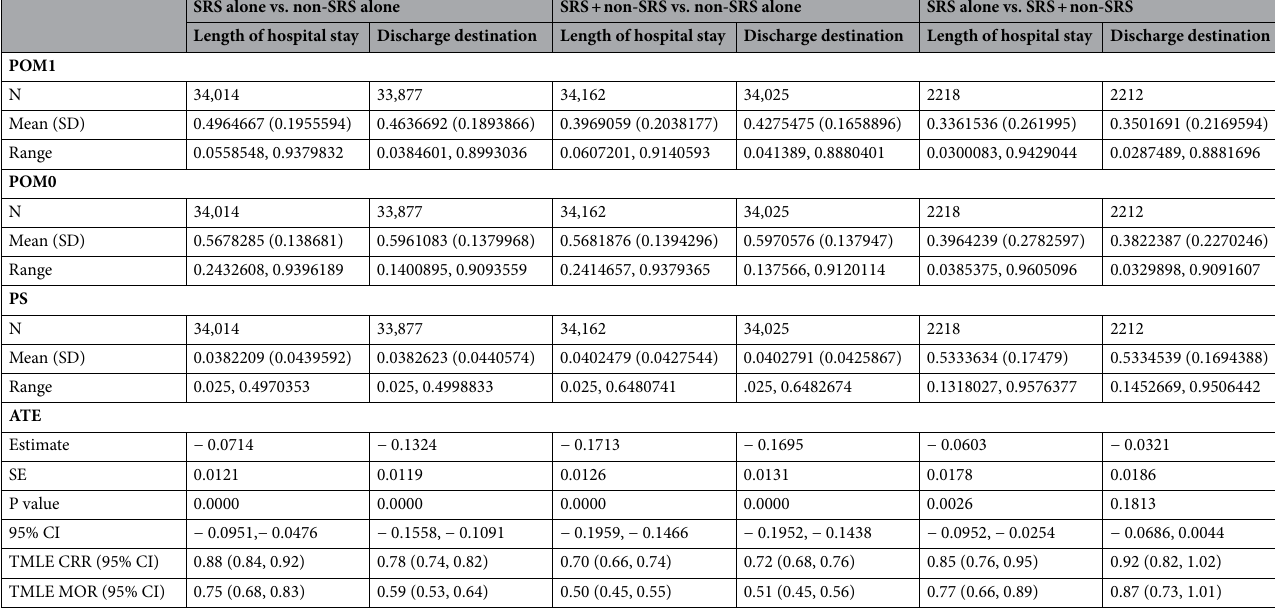
Table 3. Targeted maximum likelihood estimation of average treatment effects for SRS alone versus non-SRS alone, SRS + non-SRS versus non-SRS alone, SRS alone versus SRS + non-SRS) as predictors of hospitalization outcomes among US inpatients with brain metastases—2005–2014 Nationwide Inpatient Sample. ATE average treatment effect, CI confidence intervals, CRR causal risk ratio, MOR marginal odds ratio, POM1 potential outcome among the treated, POM0 potential outcome among the non-treated, PS propensity score, SRS stereotactic radiosurgery, TMLE targeted maximum likelihood estimation.